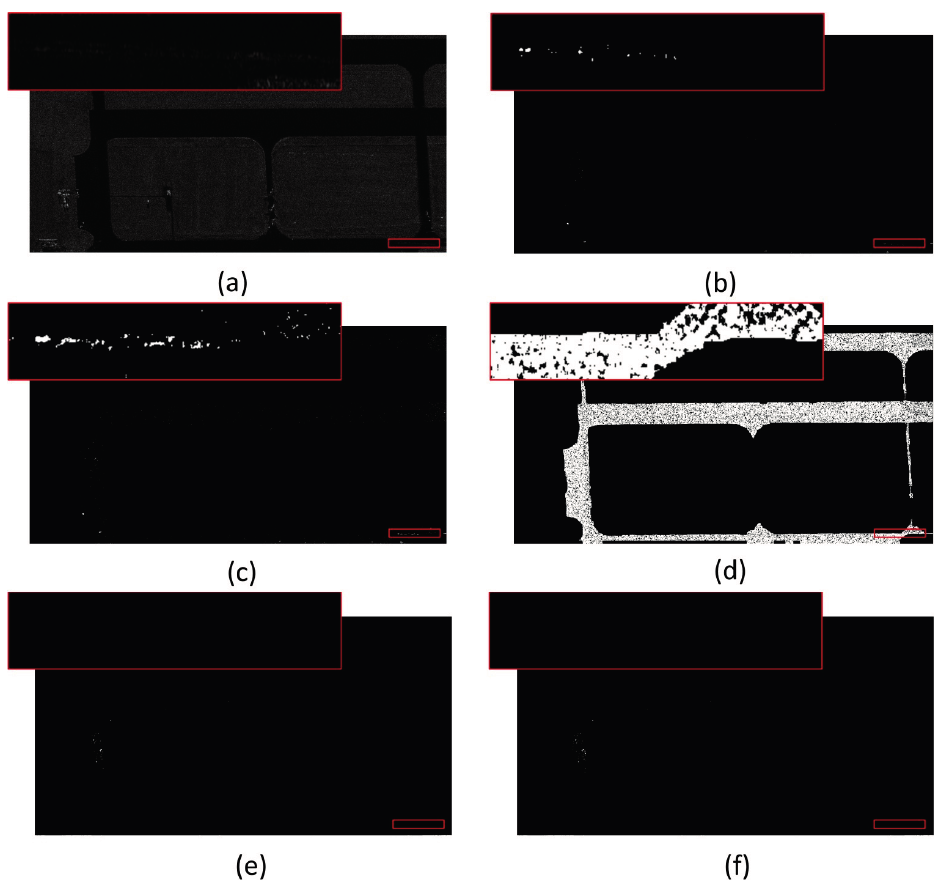
Figure 16. Results of different detectors in case of non-target. ( a ) is the original image